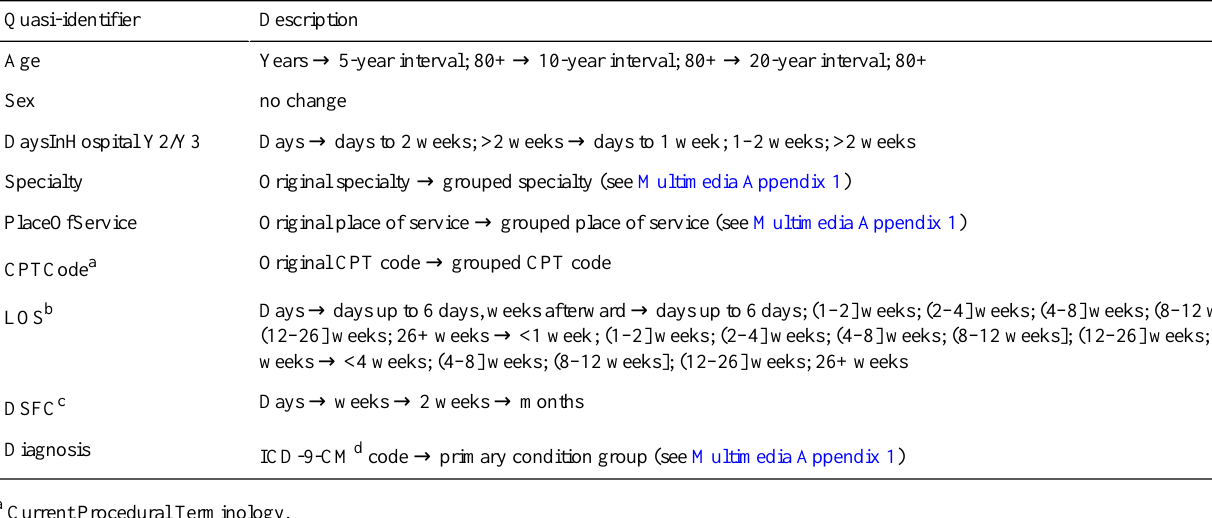
Table 4. Description of the generalization hierarchies for the